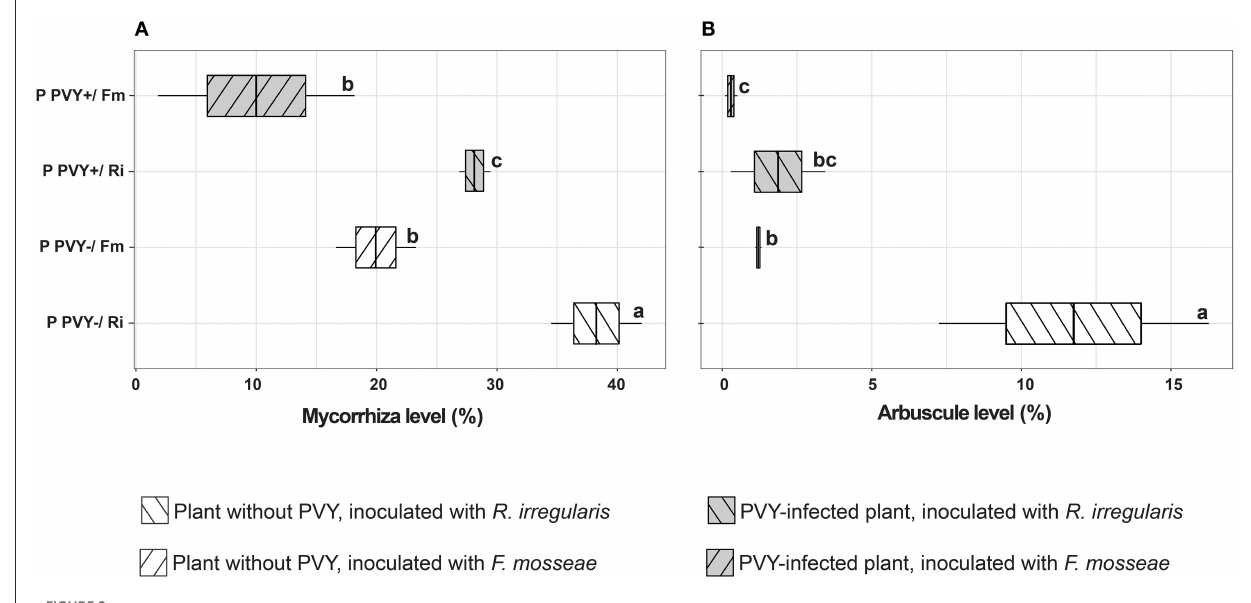
FIGURE2 Level of mycorrhiza (A) and arbuscules (B) in healthy and PVY-infected potatoes after 12 weeks of incubation. The statistically significant differences are marked with letters. The same letters indicate no significant differences ( p > 0.05).